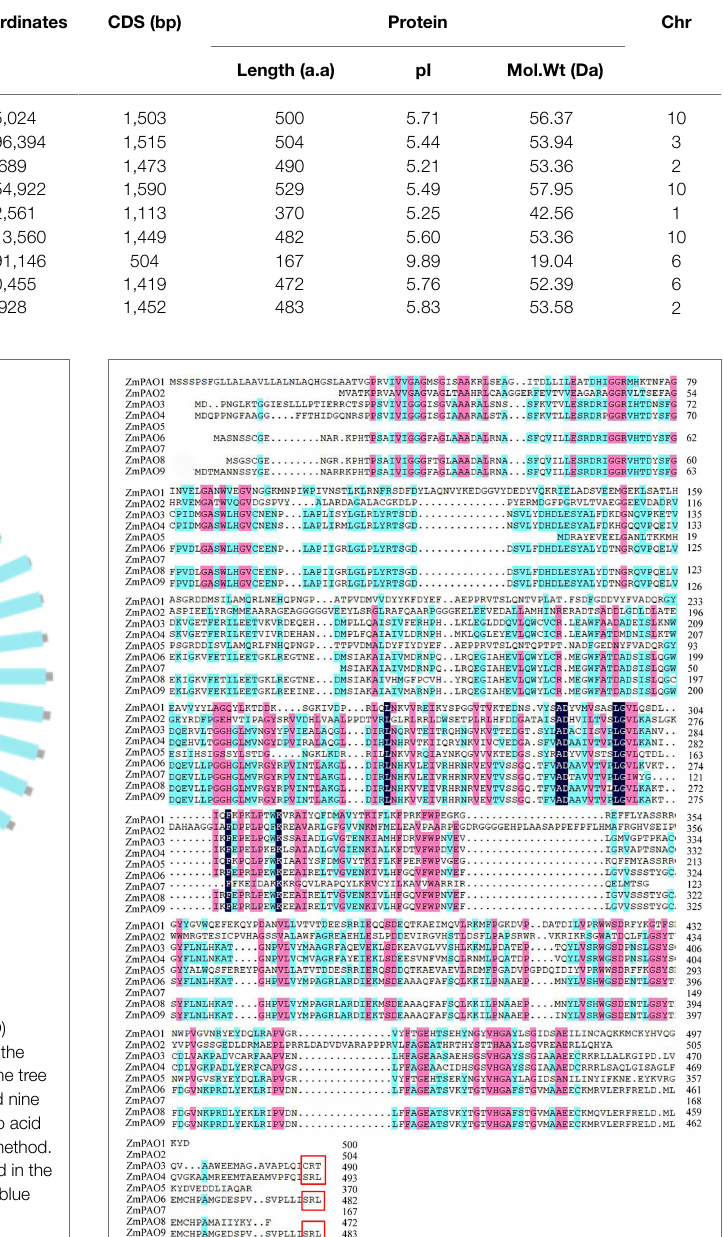
FIGURE 2 | Alignment of the amino acid sequences of maize PAO proteins. Sequence alignment was performed by DNAMAN software. Identical and similar residues are shaded in black or pink and blue background, respectively. The peroxisomal targeting signal of ZmPAO3, ZmPAO4, ZmPAO6, and ZmPAO9 are indicated in the red box.